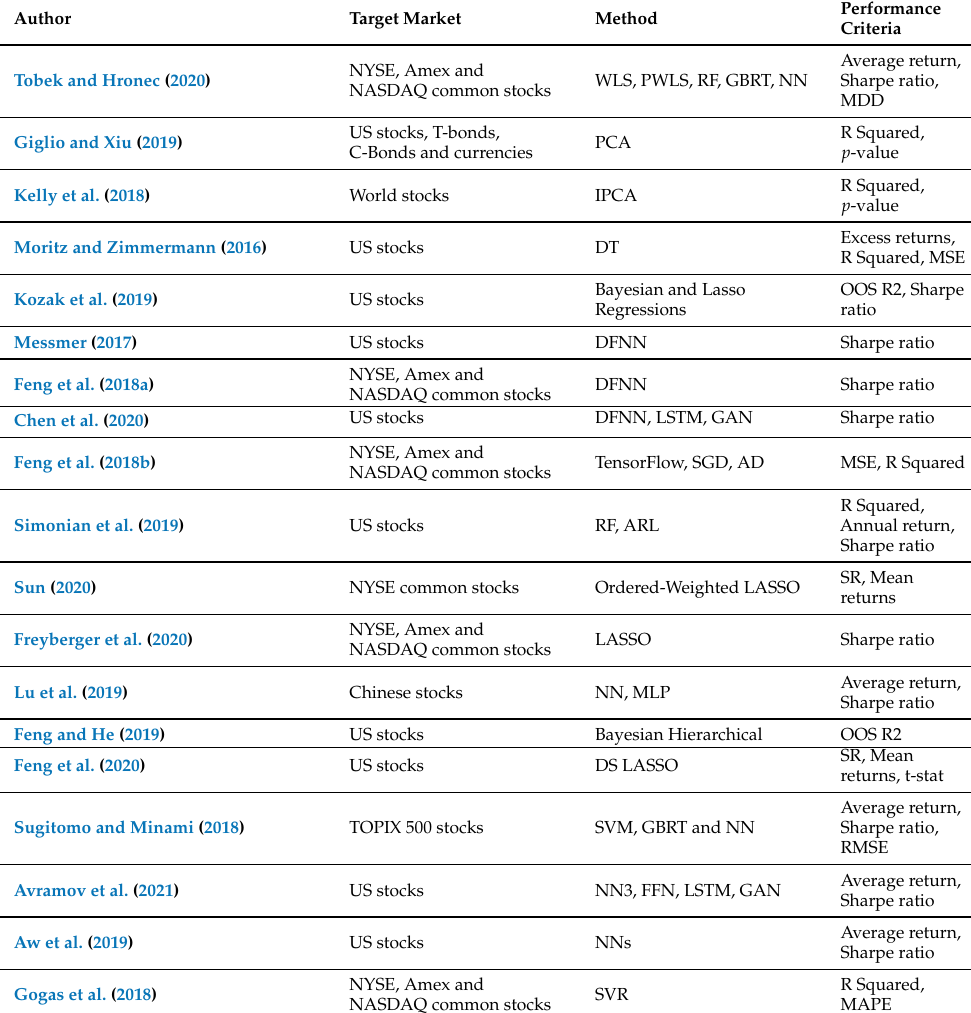
Table 3. Selection of papers for value/factor investing. Mean Absolute Percentage Error (MAPE), Out-of-the-Sample (OOS), Mean Standard Error (MSE), and Maximum Drawdown